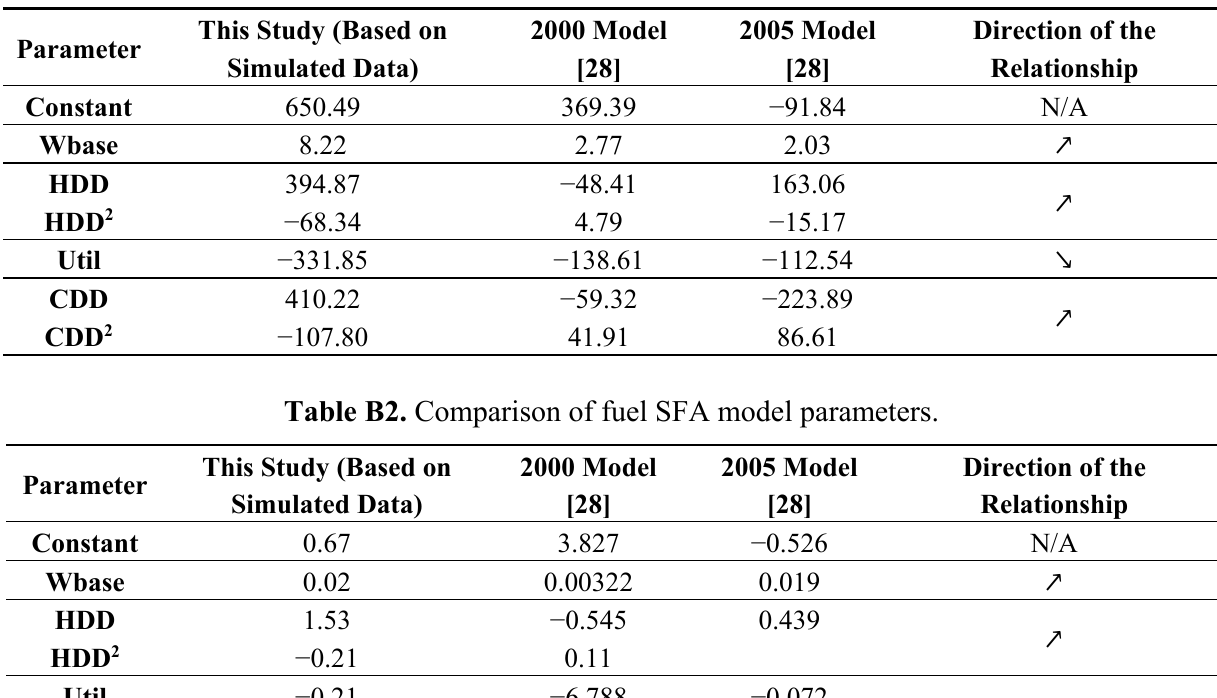
Table B1. Comparison of electricity SFA model parameters.